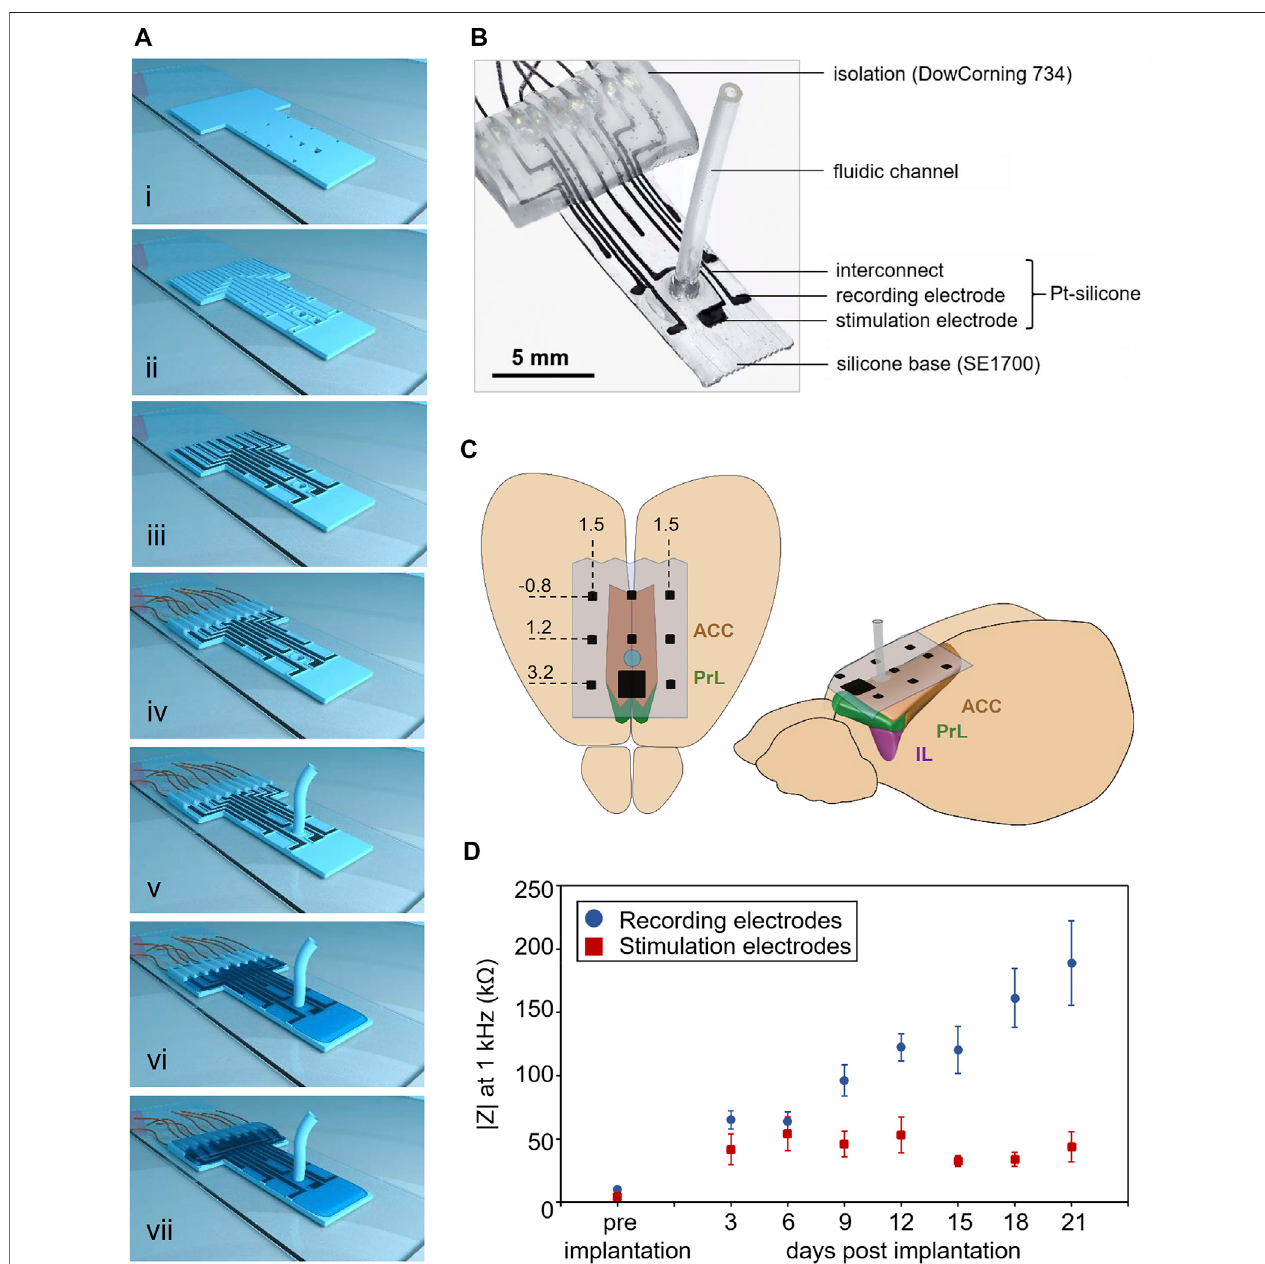
FIGURE 1 | Multimodal epicortical array for recording and modulation of neural activity. (A) i) Silicone base layer (DOWSIL ™ SE1700), including holes de fi ning the active sites of electrodes and the micro fl uidic channel. ii) A second silicone layer de fi nes the borders for electrode interconnects and the micro fl uidic channel. iii) The conductive portions of the array are formed from a platinum-silicone composite. iv) Connection of microwires. v) Connection ofsilicone fl uidic channel. vi) Isolation of the array using SYLGARD TM 184. vii) Isolation of the cable contacts using DOW CORNING ® 734. (B) Photograph of an implant (C) Implantation of the array above the rat mPFC encompassing anterior cingulate (ACC), prelimbic (PrL) and infralimbic (IL) cortices. Stereotactic coordinates (mm) relative to bregma. (D) Impedances in vitro (at1 kHz)ofrecording(blue,n (cid:1) 80electrodesof10implants)andstimulationelectrodes(red,n (cid:1) 10electrodesof10implants)and invivo (varyingimplantnumbers,see Supplementary Table S2 ). Data are presented as mean ±